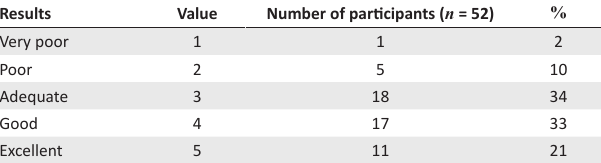
TABLE 3: Question 9a: Level of community participation in development needs and priorities.